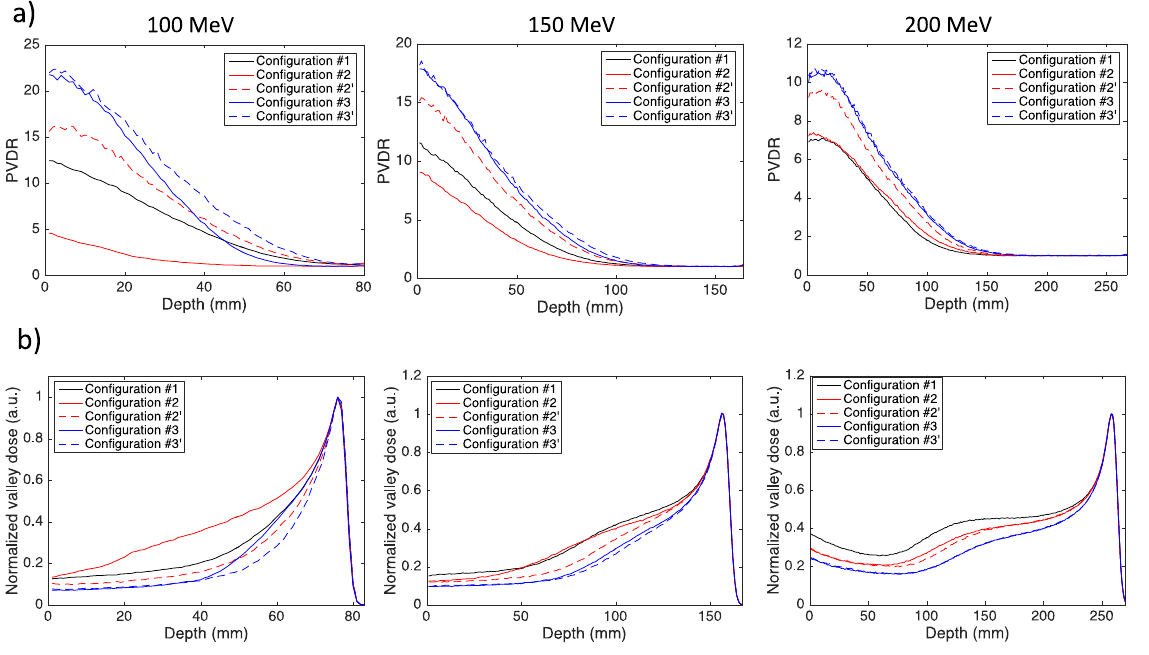
Figure 4. ( a ) Peak-to-Valley Dose Ratio (PVDR) as a function of depth and ( b ) depth dose of the first central valley in the five analyzed configurations for three different proton energies.